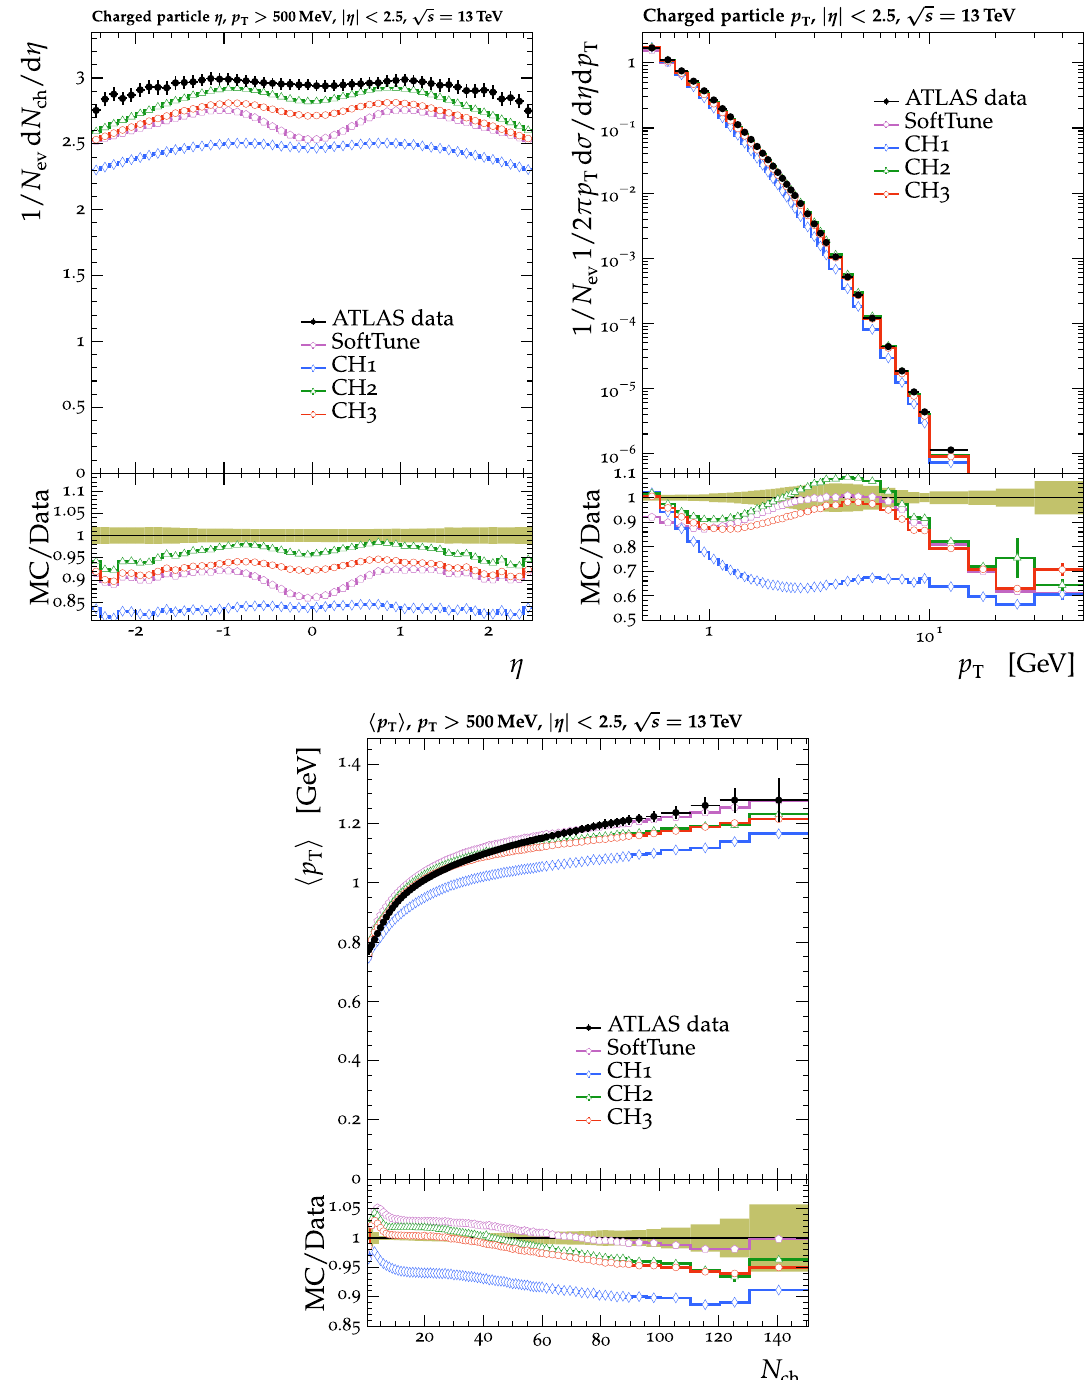
Fig. 24 Normalized plots [48] for the pseudorapidity of charged par- ticles (upper left), charged-particle p T distribution (upper left), and the mean charged-particle p T distribution as a function of the charged- particle multiplicity (lower), all for | η | < 2 . 5. ATLAS MB data are